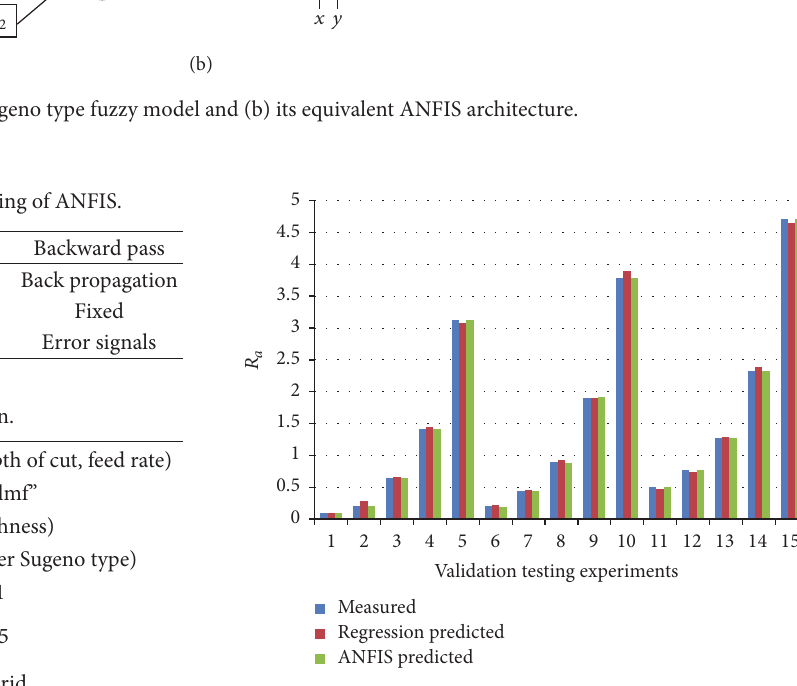
Figure 10: Column chart for measured 𝑅 𝑎 versus predicted 𝑅 𝑎